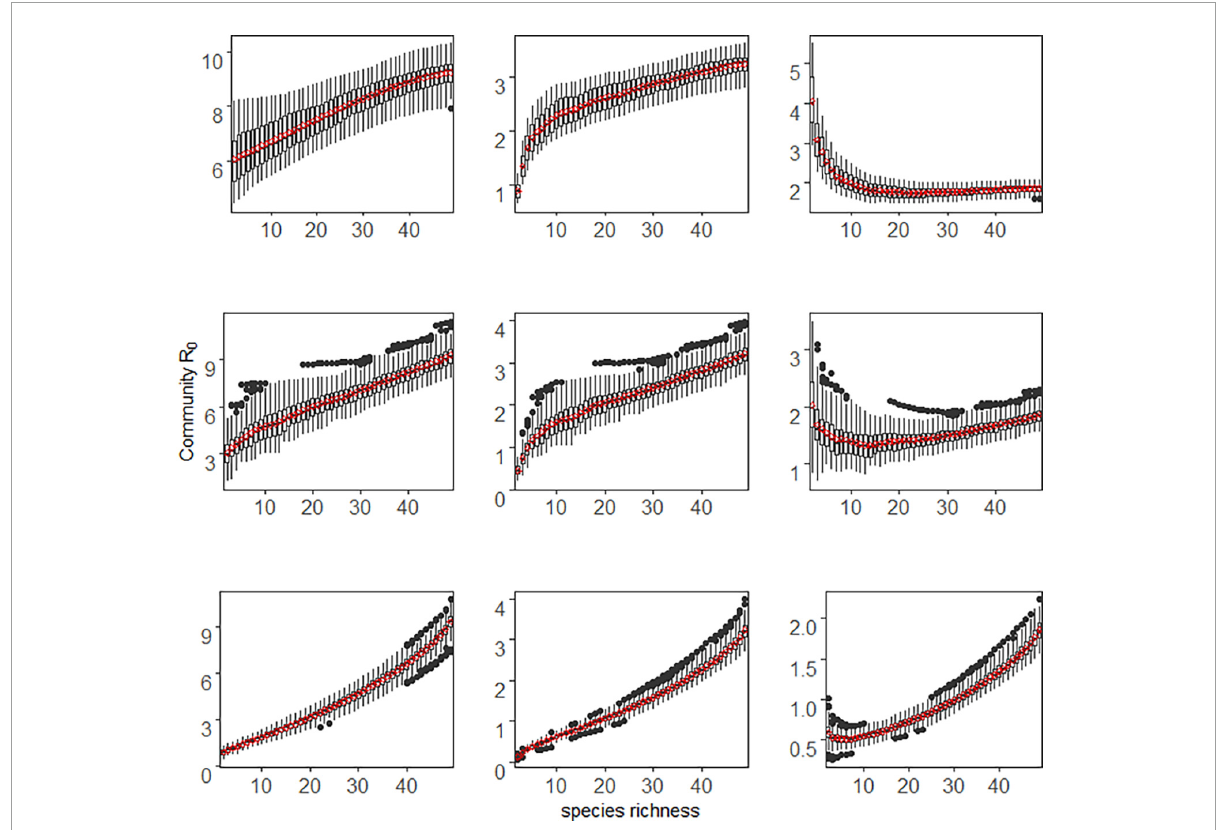
FIGURE2 The relationship between host species richness and community R 0 under density-dependent transmission and deterministic extinction scenario. Other details are the same as in Figure 1 .